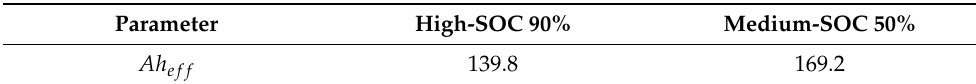
Table 2. Effective Ah-throughput for the battery-only